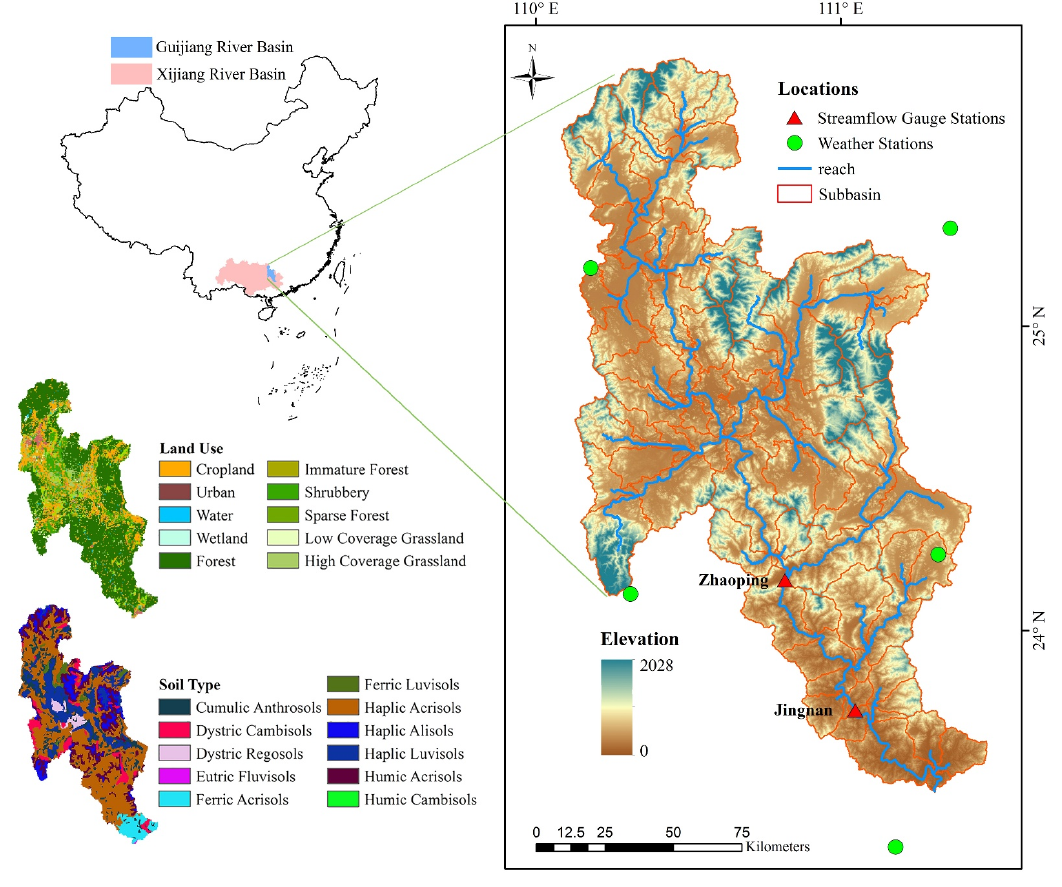
Figure 1. Location, digital elevation model (DEM), land use, and soil types of the Guijiang River Basin.